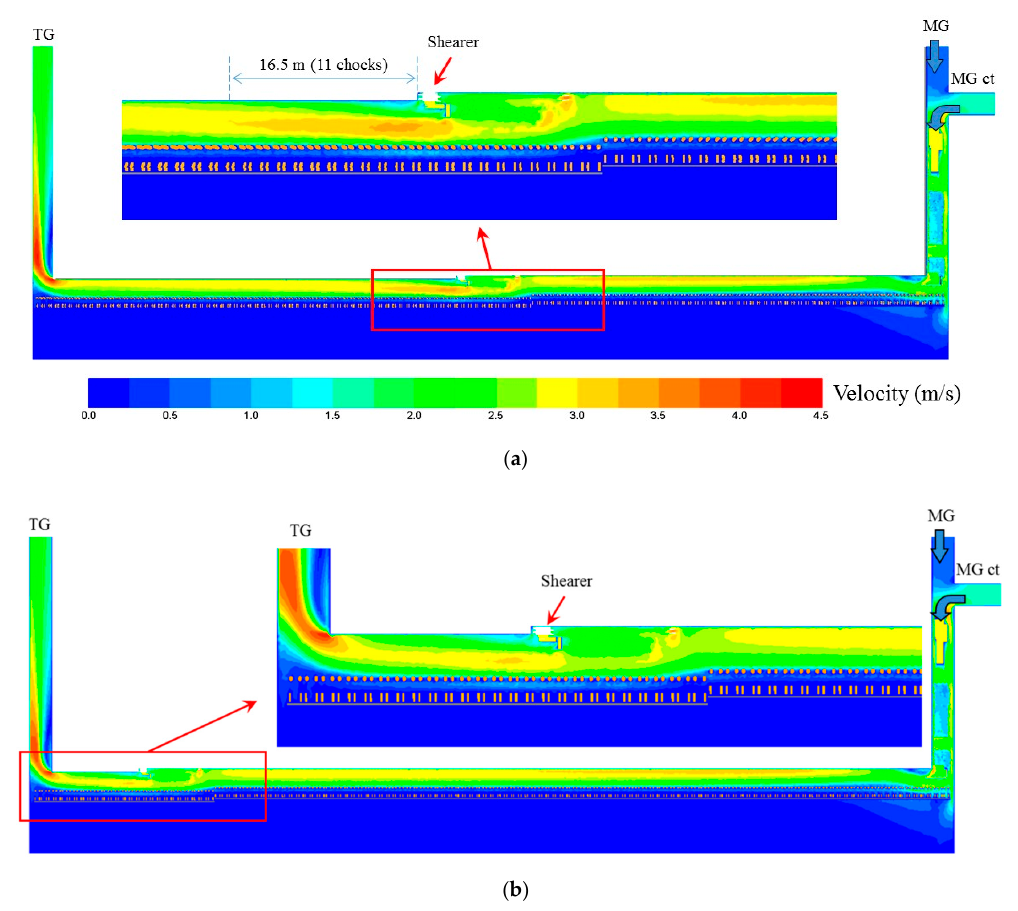
Figure 9. Velocity contour at 2 m above floor for MG-TG Case 2 and Case 3: ( a ) MG-TG Case 2; ( b ) MG-TG Case 3.